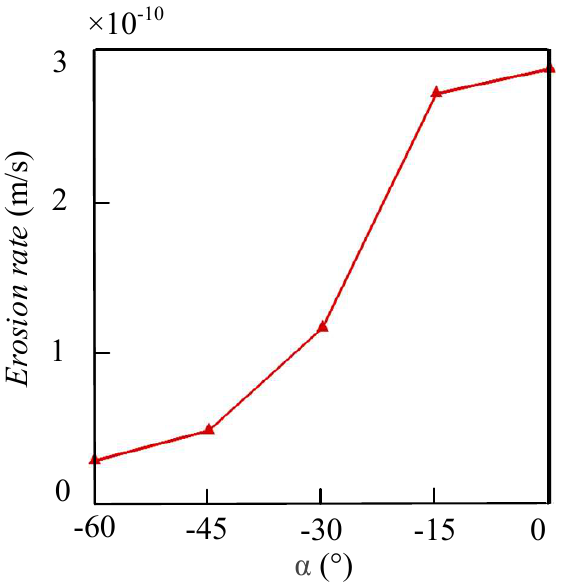
Figure 14. The averaged erosion rate of the dielectric wall corresponding to different values of the negative α.